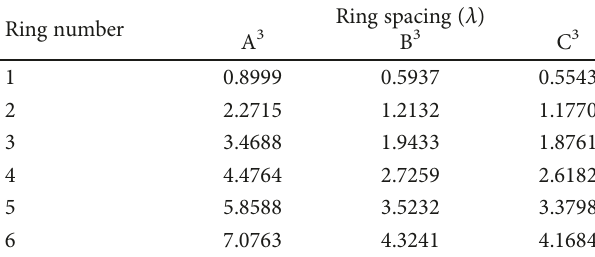
Table 7: The ring spacing for individuals A 3 , B 3 , and C 3 .